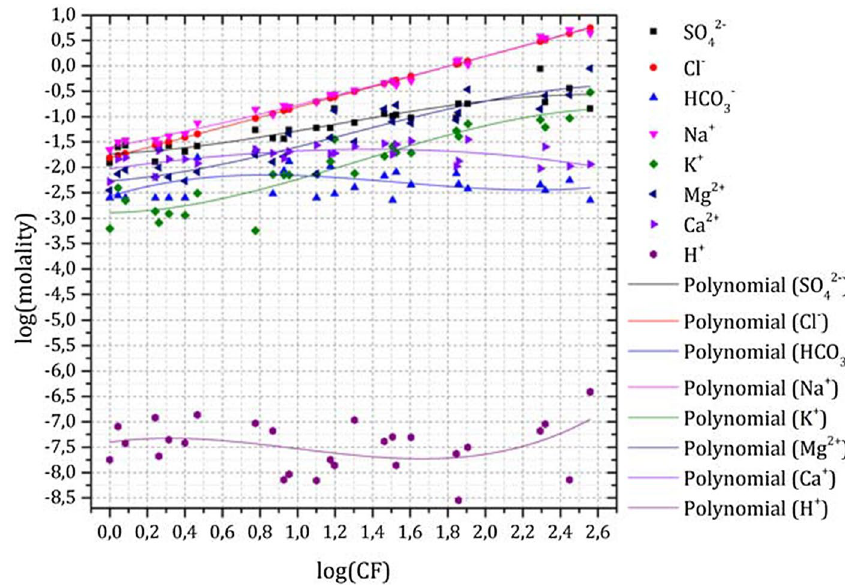
Fig. 7 H + ion concentration